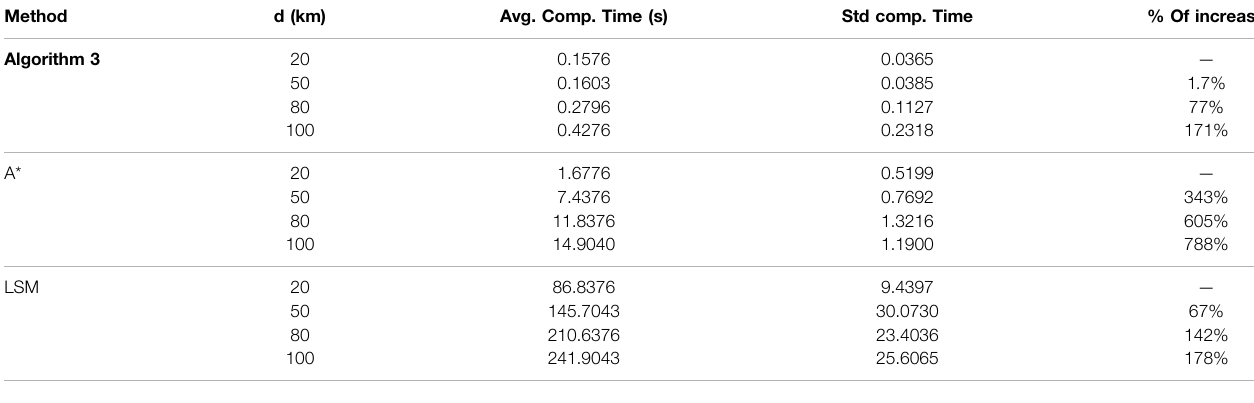
TABLE 2 | Computation time comparison of A*, Level Set Method, and the proposed algorithm. Avg. comp. time represents the averaged computation time for each simulation scenario, and STD comp. time represents the standard deviation of the computation time. % of increase describes the percentage increase in the computation cost when d increases.